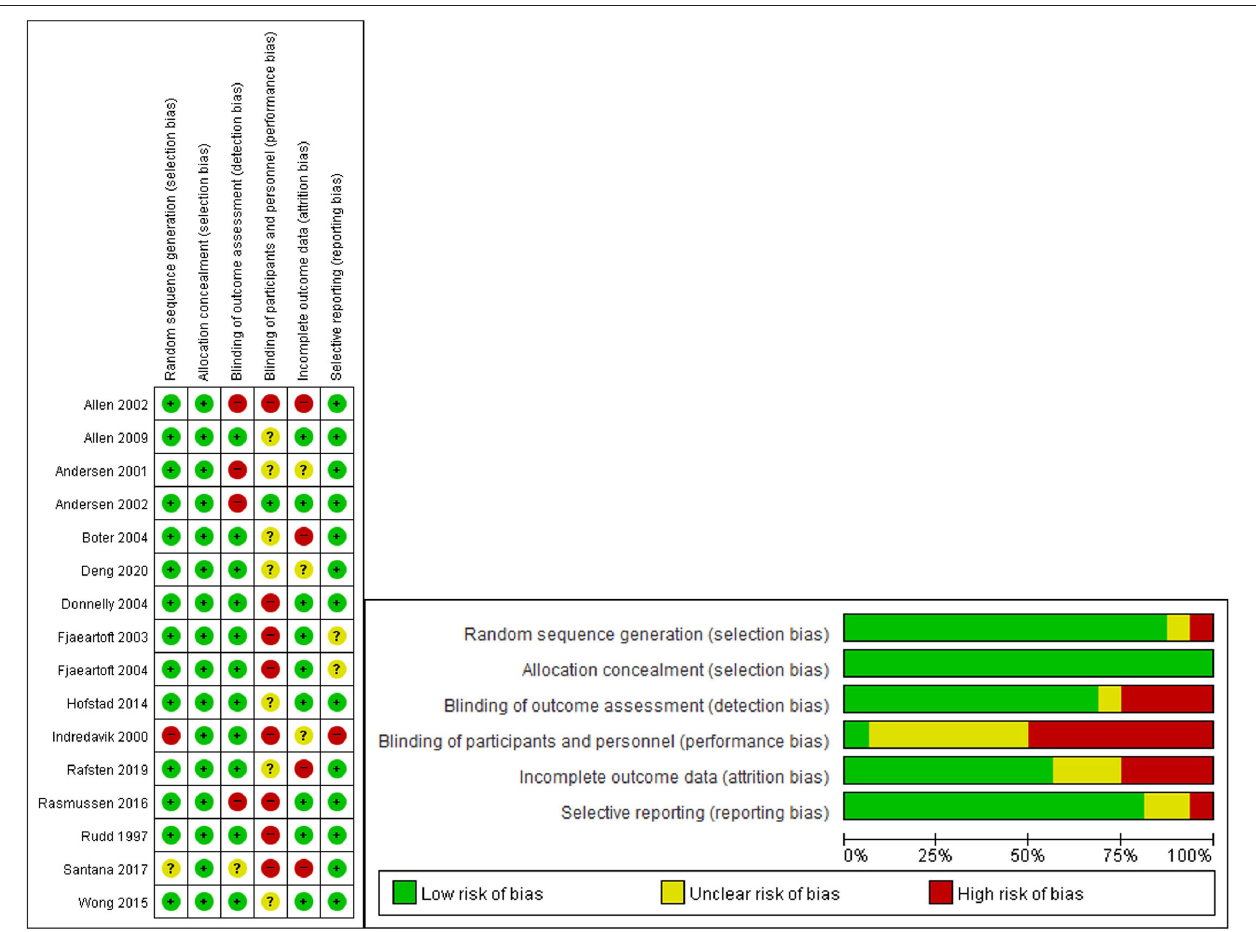
FIGURE 7 | “Risk of bias” graph: review authors’ judgments about each risk of bias item presented as percentages across included studies. “Risk of bias” summary: review authors’ judgments about each risk of bias item for each included